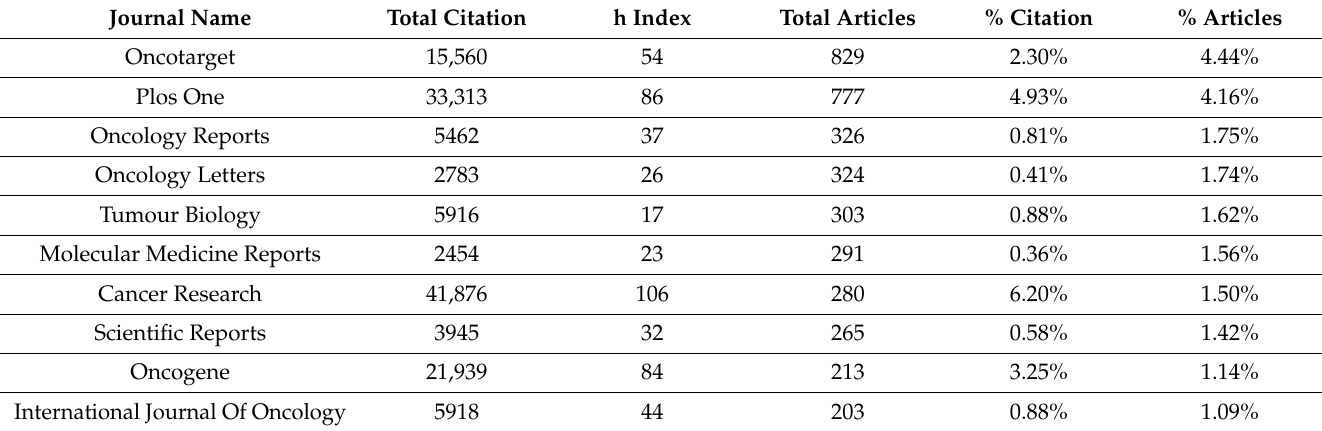
Table 7. Top 10 journals.